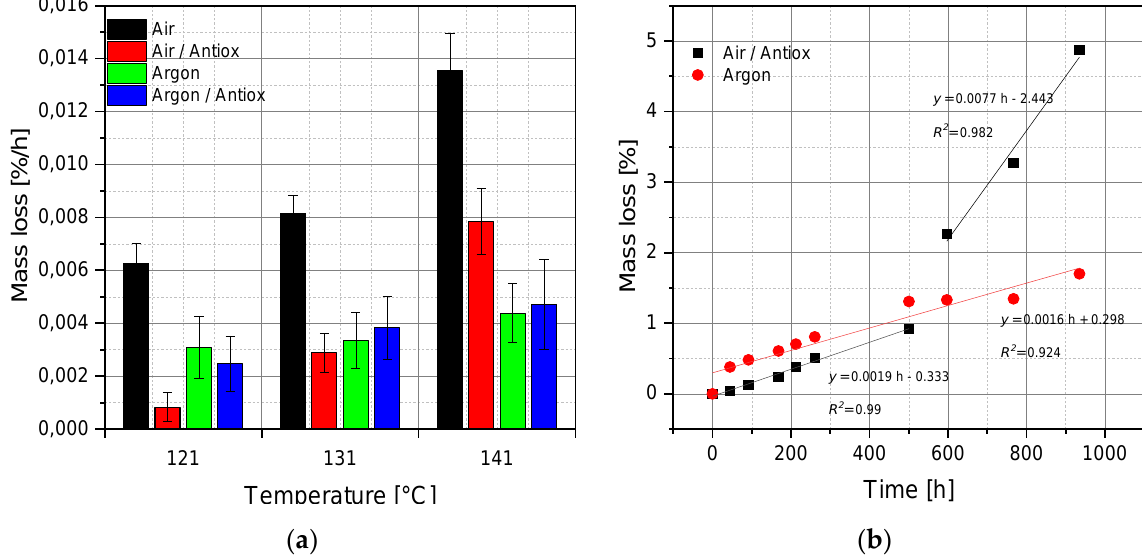
Figure 2. ( a ) Percentage of mass loss per hour at 121 °C, 131 °C and 141 °C for short-term tests. ( b ) Percentage of mass loss at 141 °C for long‐term test.